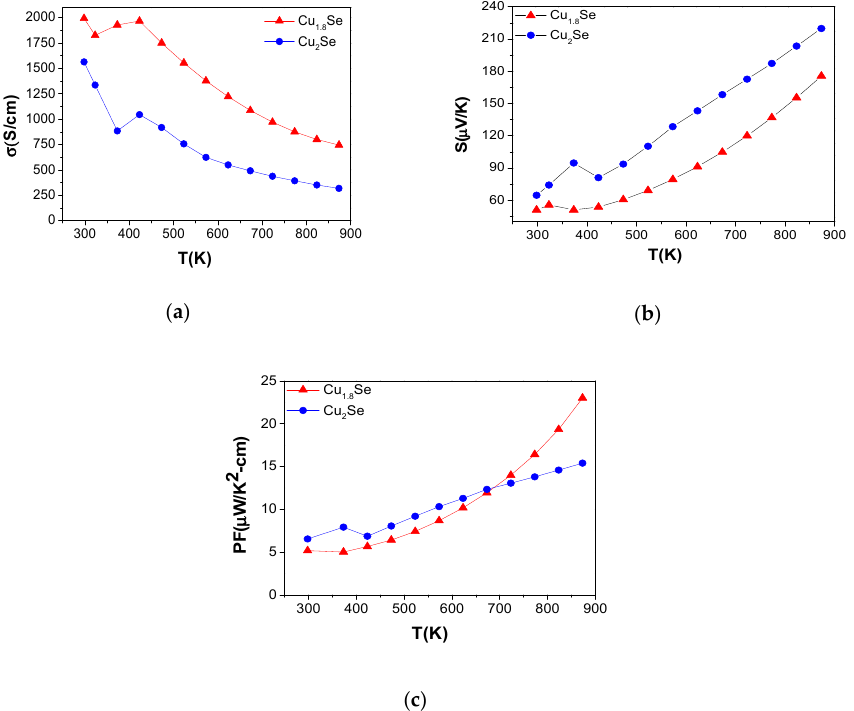
Figure 6. Electronic transport values as a function of temperature for Cu 2 Se and Cu 1.8 Se in the temperature range of 300 to 87 5K: ( a ) electronic conductivity ( σ ), ( b ) Seebeck coefficient ( S ); ( c ) power factor ( S 2 σ ). The non-monotonous behavior of measured quantities in the temperature range of 300–400 K is due to the structural phase transition of Cu 2 Se. Nanomaterials 2020 , 10 , x FOR PEER REVIEW